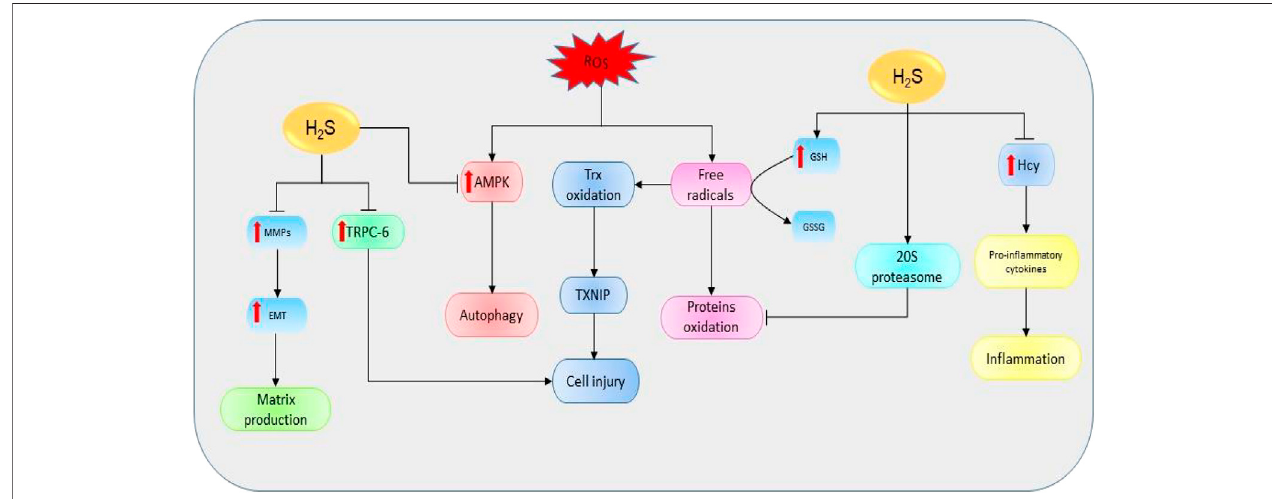
FIGURE 4 | The diagrammatic illustration of the in fl uence of H 2 S on the mechanisms involved in the initiation and development of renal diseases. H 2 S suppresses the elevation of Hcy resulting in the downregulation of proin fl ammatory cytokines (such as IL-1 β , IL-6, and NF- қ B) and the corresponding reduction of proin fl ammatory activities.Moreover,H 2 Sincreasestheexpressionsof20Sproteasomewhichthenreducestheoxidationofproteinsbymediatingproteolyticdegradationoftheoxidized proteins. Next, H 2 S can also stimulate the oxidation of GSH to GSSG resulting in the reduction of free oxygen radicals and subsequent suppression of protein oxidation.Byreducingfreeoxygenradicalslevel,H 2 SalsopreventstheoxidationsofTrxanditsbindingintoTXNIPresultinginreductionofcellinjury.Next,H 2 Sprevents the ROS-mediated activation of AMPK pathway and its downstream effect on the induction of autophagy. Similarly, H 2 S reduces the expressions of MMPs and their resultingeffectsinEMTandmatrixproduction.Also,H 2 SsuppressesthelevelsofTRPC-6leadingtoareductionincellinjury.Alternatively,thedeclineinH 2 Slevelscould reverse the protective effects, resulting in the promotion of mechanisms favoring the development of kidney diseases (H 2 S, hydrogen sul fi de; Hcy, homocysteine; GSH, glutathione; GSSG, oxidized glutathione; ROS, reactive oxygen species; TRPC-6, transient receptor potential cation channel, subfamily C, member 6; MMPs, matrix metalloproteinases; EMT, epithelial-mesenchymal transition; Trx, thioredoxin; TXNIP, Trx-interacting protein; AMPK, AMP-activated protein kinase).